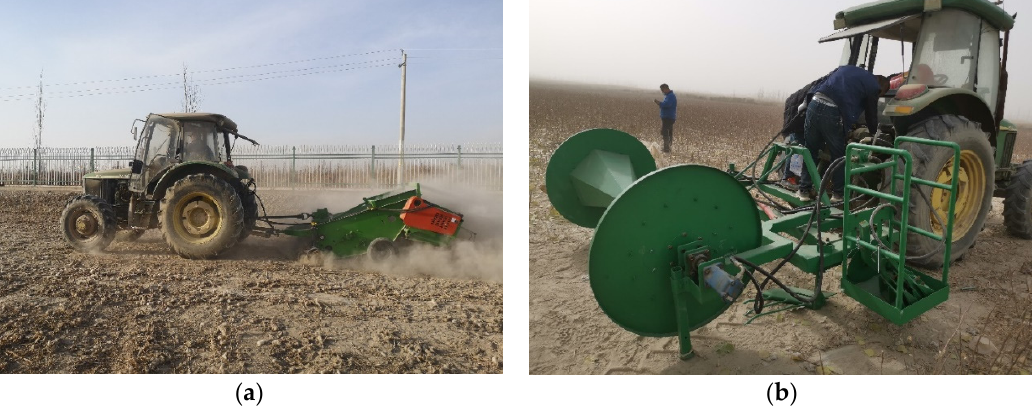
Figure 8. Test field of curl ‐ up collecting of film. ( a ) 11SM ‐ 1.2 curl ‐ up film collector; ( b ) 1JRM ‐ 2000 curl ‐ up film collector.